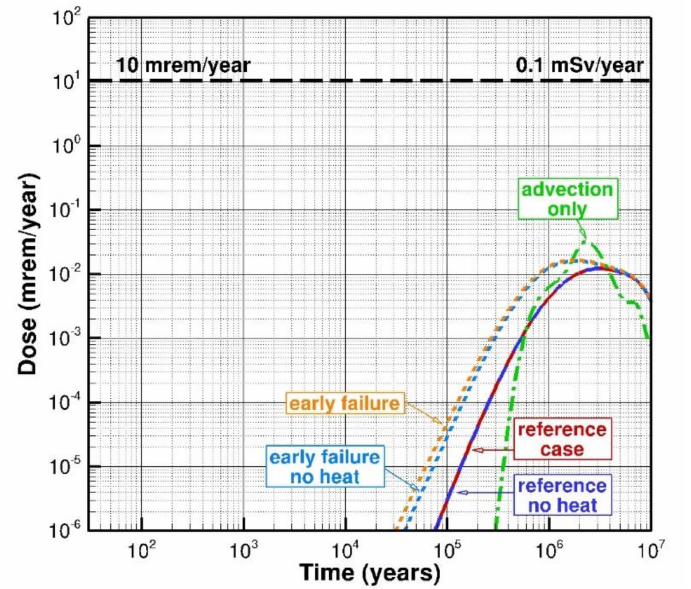
Figure 7. Sensitivity of 129 I dose curve to thermal driving force, backfilling and early canister failure, and diffusion